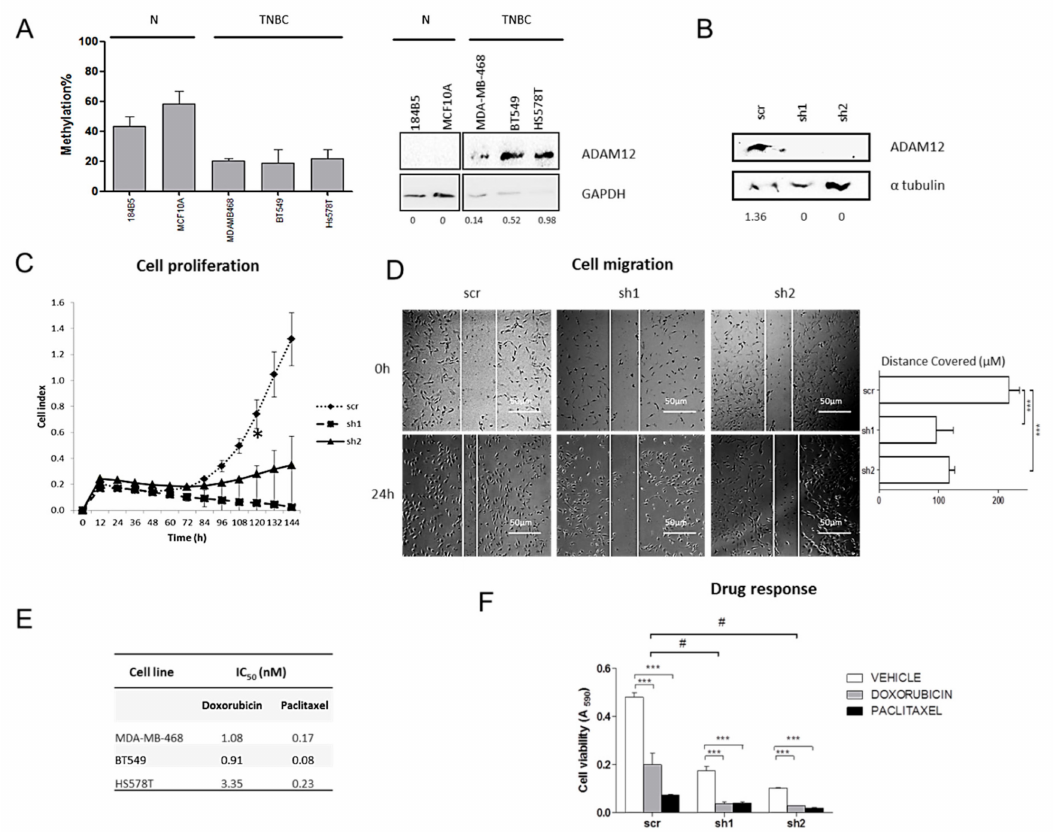
Figure 6. E ff ects of ADAM12 silencing on TNBC cell lines. ( A ) ADAM12 methylation (left panel) and protein (right panel) levels were assessed by pyrosequencing and western blot respectively, in a panel of two non-neoplastic mammary cells (N) and three TNBC cell lines. Numbers indicate